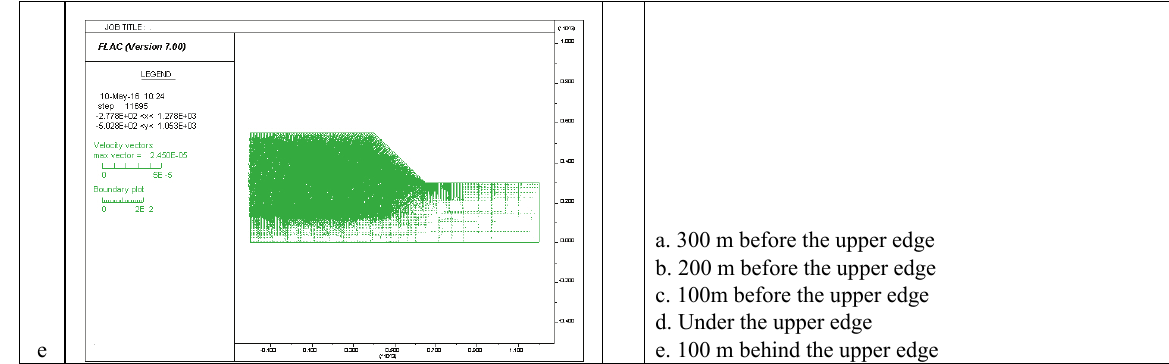
Fig. 16. Velocity vectors at particular stages of the longwall operation proceeding from the right side towards the lower edge of slope (measured point is the face of the longwall panel)